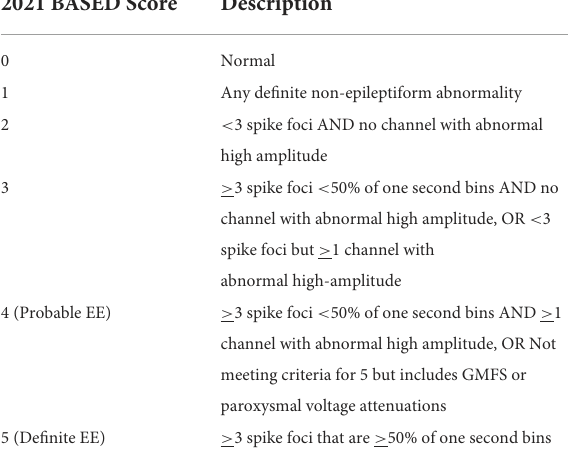
TABLE 2 Description of BASED scores using the 2021